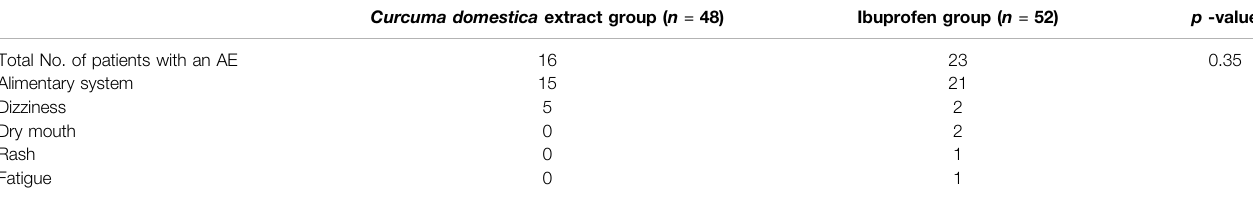
TABLE 1 | Adverse reactions to curcuma extracts in knee OA and ibuprofen